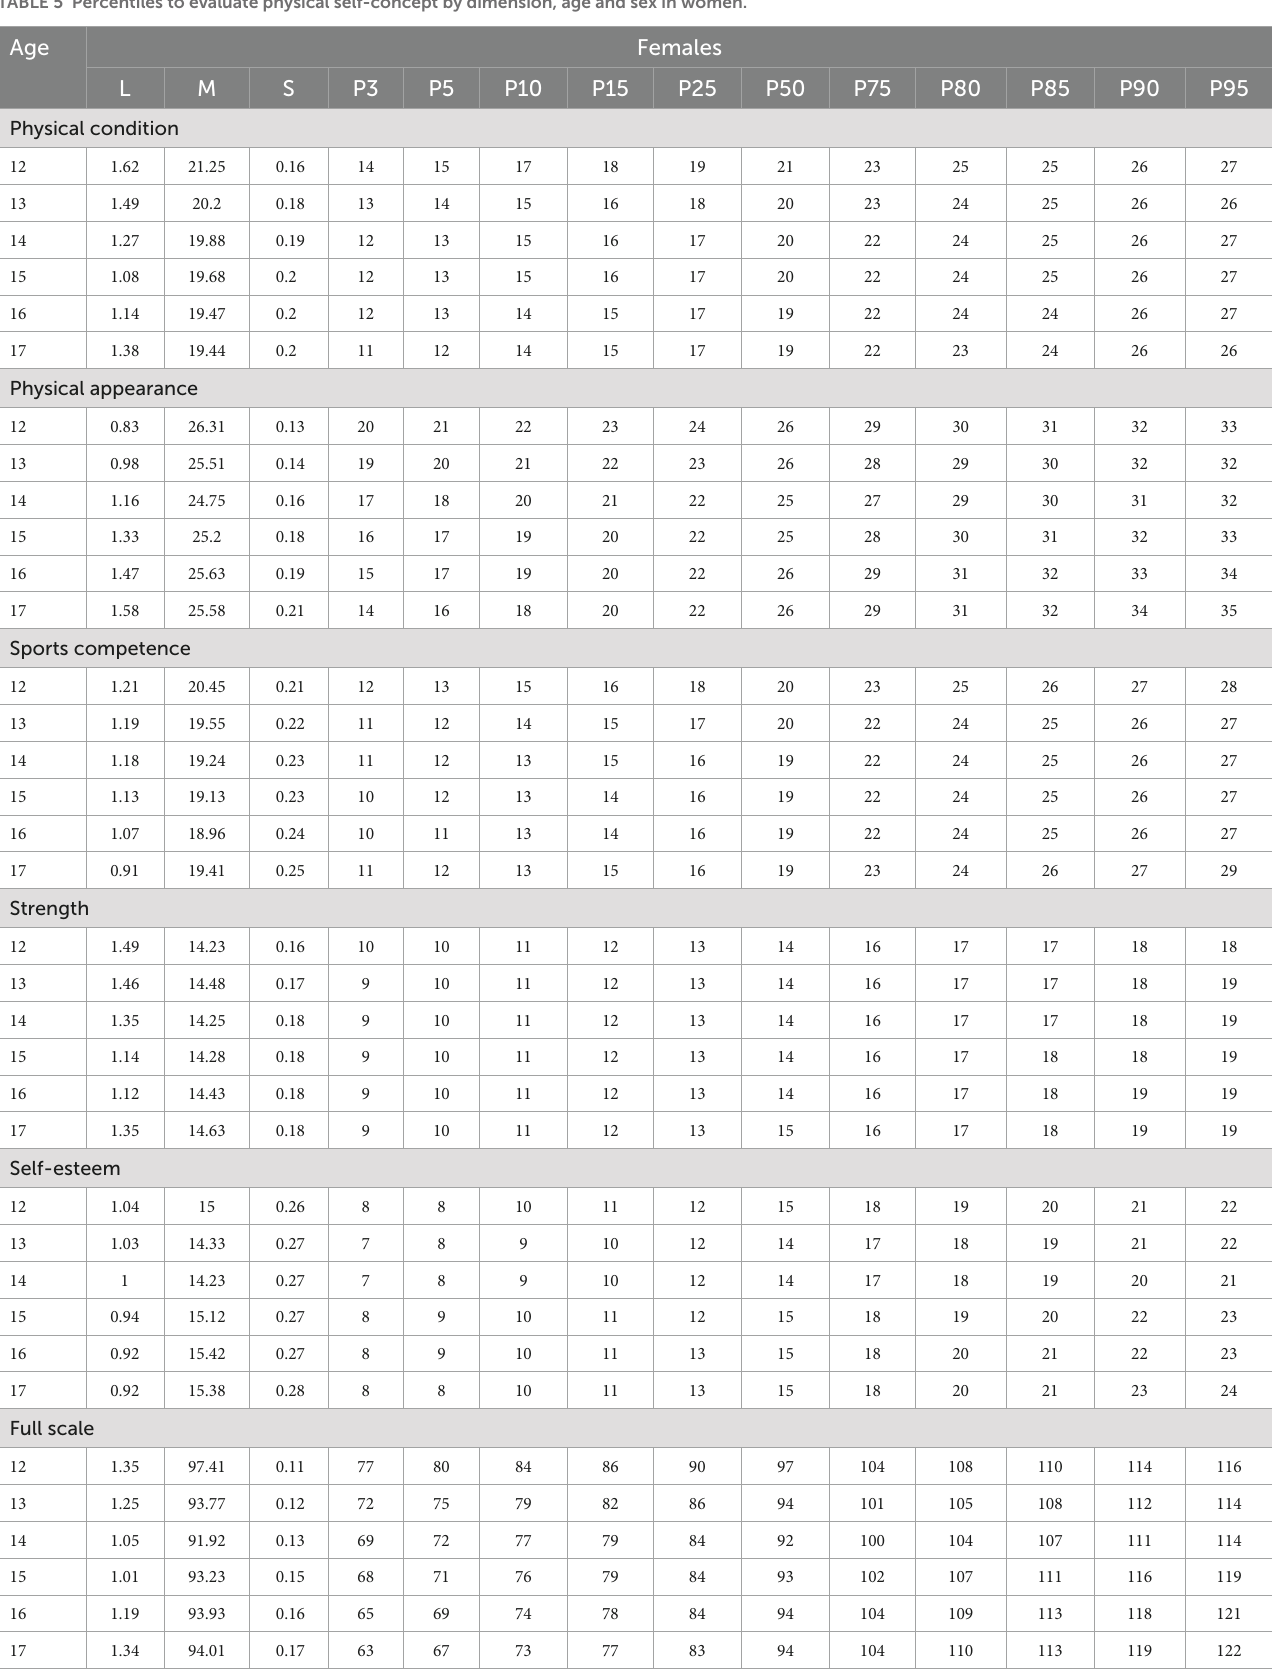
TABLE 5 Percentiles to evaluate physical self-concept by dimension, age and sex in women. Age